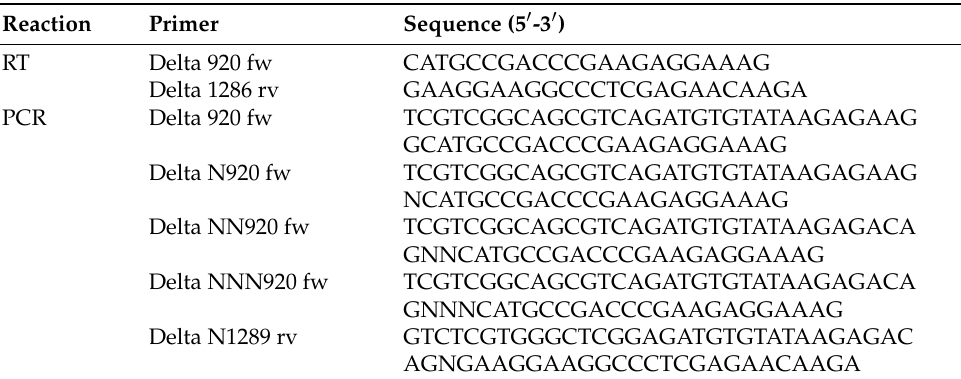
Table A1. Primers used in the different RT-PCR